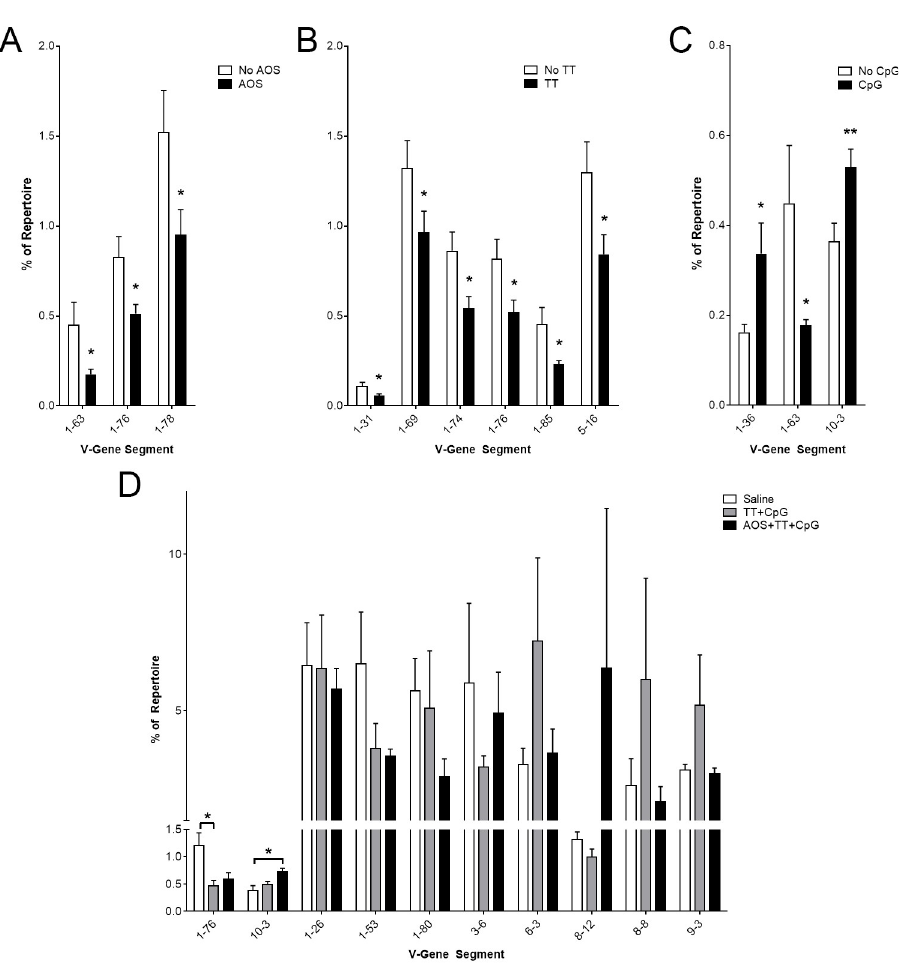
Fig 2. Impact of AOS, tetanus toxoid, and CpG on Splenic B cell VH-gene segment usage. Mice subjected to one or more treatment variables: Significantly different V-gene segment usage by main effect for AOS (A), TT (B), and CpG (C). (D) Significantly different V-gene segment usage and high frequency V-gene segment usage in saline, TT+CpG, and AOS+TT+CpG treatment groups. � = P < 0.05, �� = P < 0.01, ��� = P < 0.001.